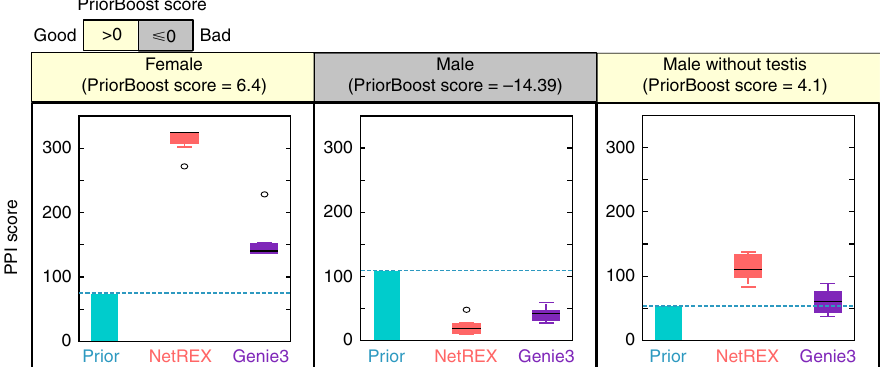
Fig. 3 Estimating the usefulness of the prior network for the task of inferring sex-speci fi c GRNs for Drosophila . The relevance of a prior network is estimated by PriorBoost scores where negative score indicate that the prior might be misleading. As an additional test we used PPI score which evaluates the topology of a network independently of its relation to expression data. When the PriorBoost scores are positive, PPI scores of NetREX are higher than GENIE3. For each box in the boxplot, the central mark (black line) indicates the median, and the bottom and top edges of the box indicate the 25th and 75th